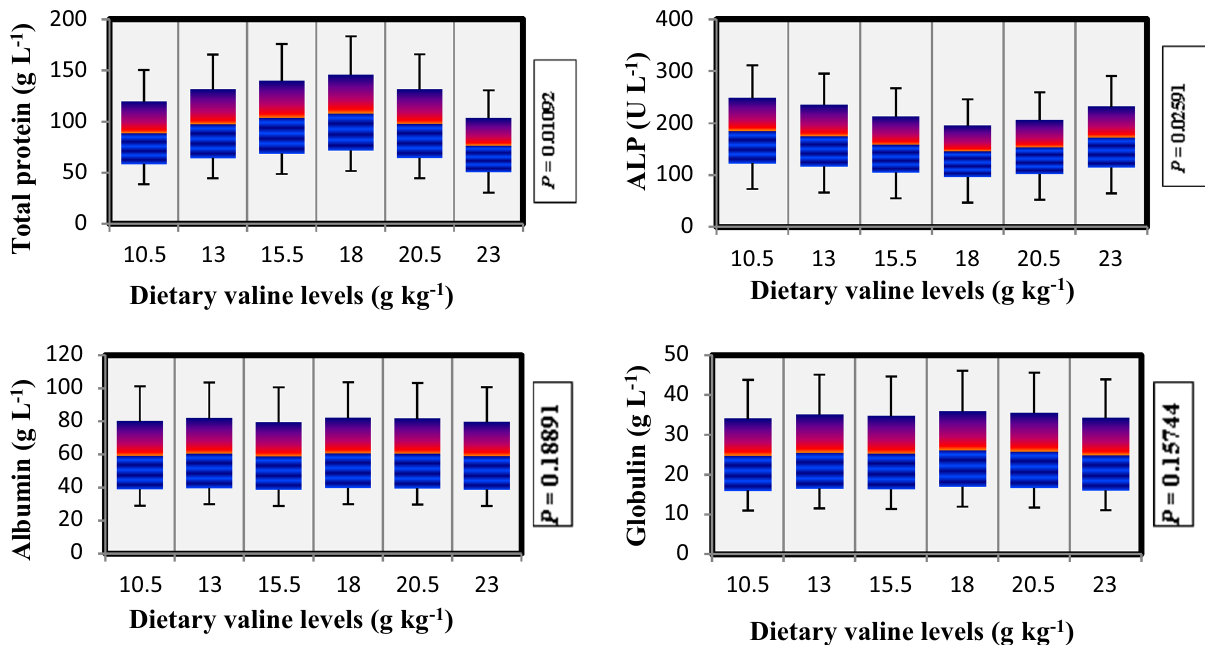
Figure 3. Non-specific immune response of rainbow trout, Oncorhynchus mykiss fingerlings fed diets containing graded levels of valine (g kg −1 ).